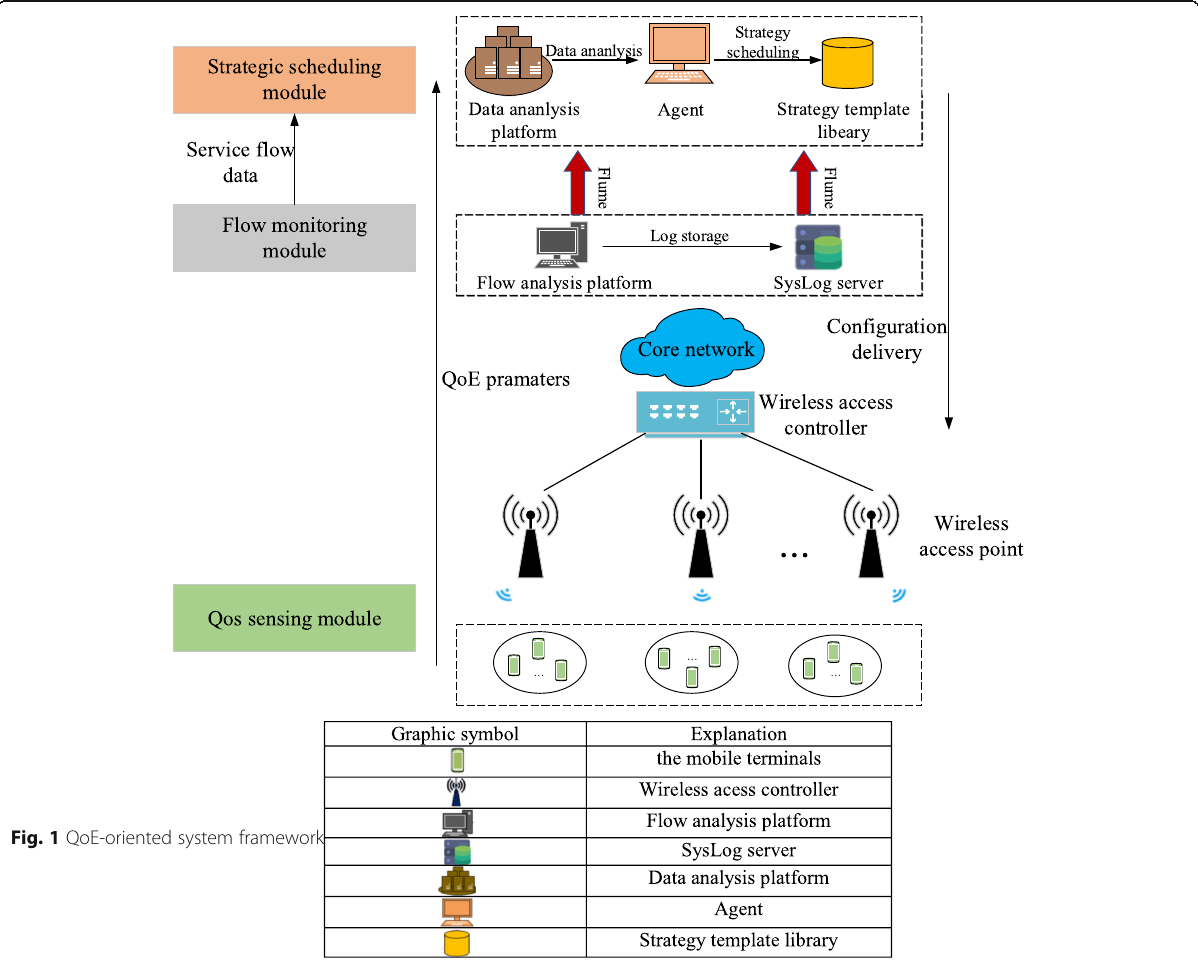
Fig. 1 QoE-oriented system